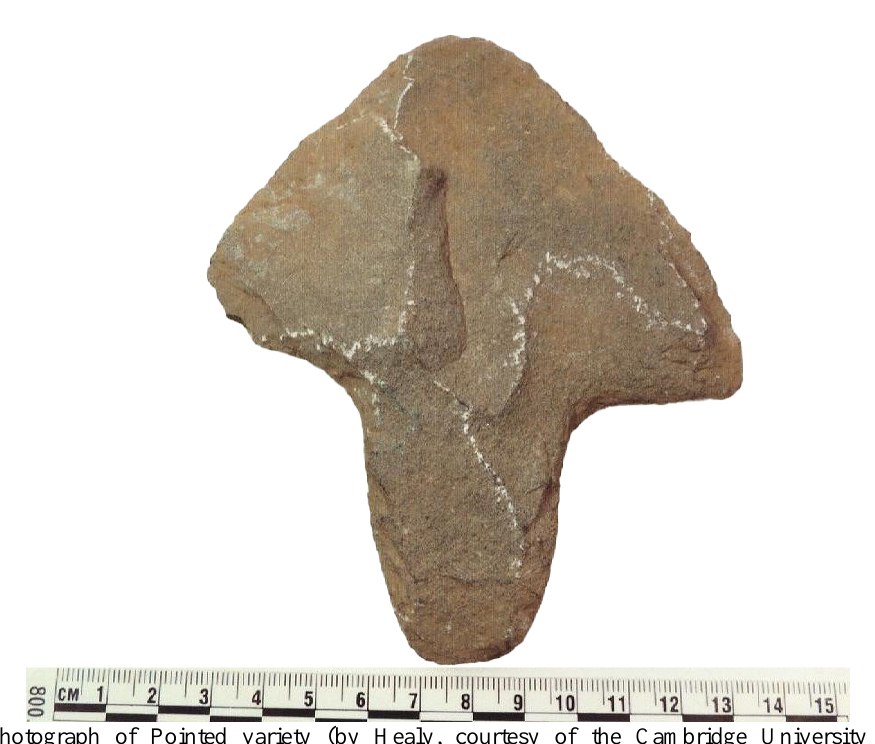
Figure 2. Photograph of Pointed variety (by Healy, courtesy of the Cambridge University Museum of Archaeology and Anthropology; Cat. No. 1946.166N; scale in cm).